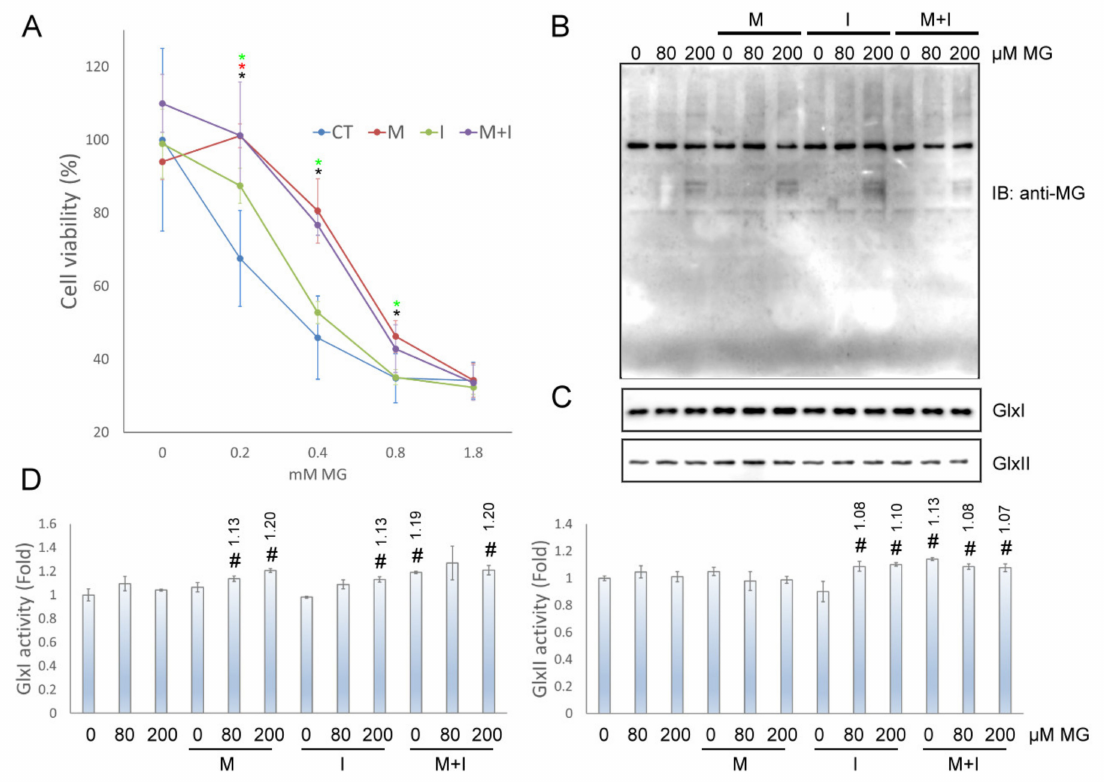
Figure 3. The effects of insulin and metformin on MG assaults in HEK293T cells. ( A ) Viability of HEK293T cells cultured at various concentrations of MG in the absence or presence of insulin and metformin for 4 h. ( B ) AGE formation, ( C ) enzyme level of GlxI and GlxII, and ( D ) enzyme activity of GlxI and GlxII in HEK293T cells at various MG concentrations in the absence or presence of insulin and metformin for 4 h. MG: MG. M: 10 mM metformin; I: 10 ng/mL insulin; M+I: 10 mM metformin + 10 ng/mL insulin. Results with significant difference at p < 0.05 are indicated by * metformin treated cells, * insulin treated cells, and * metformin/insulin co-treated cells compared to control cells under the same MG concentration ( n = 4). Enzyme activity significantly different from control at p < 0.05 is indicated by # ( n =